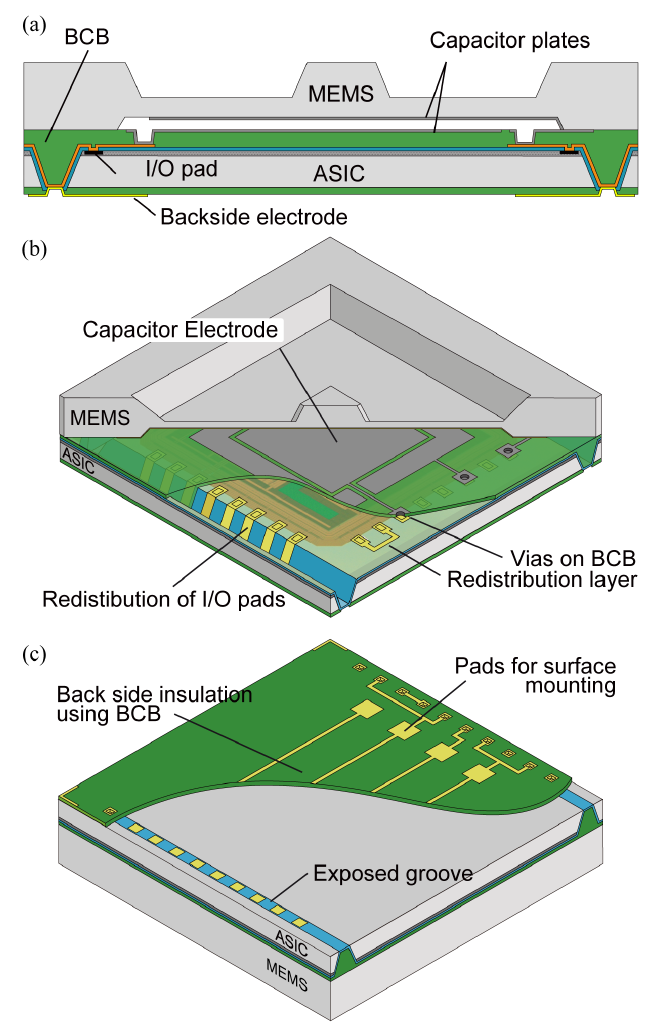
Figure 2. Device structure: ( a ) cross section of the chip; ( b ) top side; ( c ) back